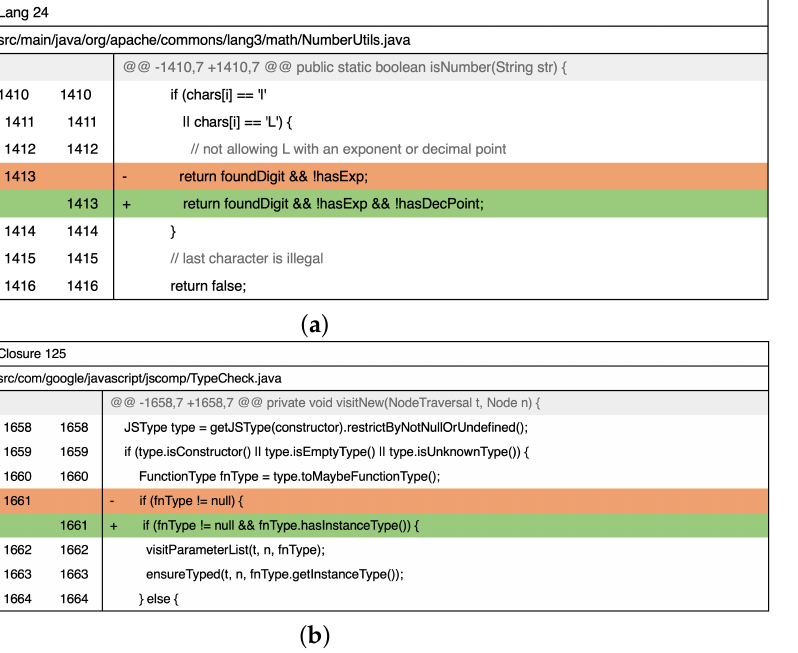
Figure 1. Example of search space problem. ( a ) Developer patch of Lang-24; ( b ) Developer patch of